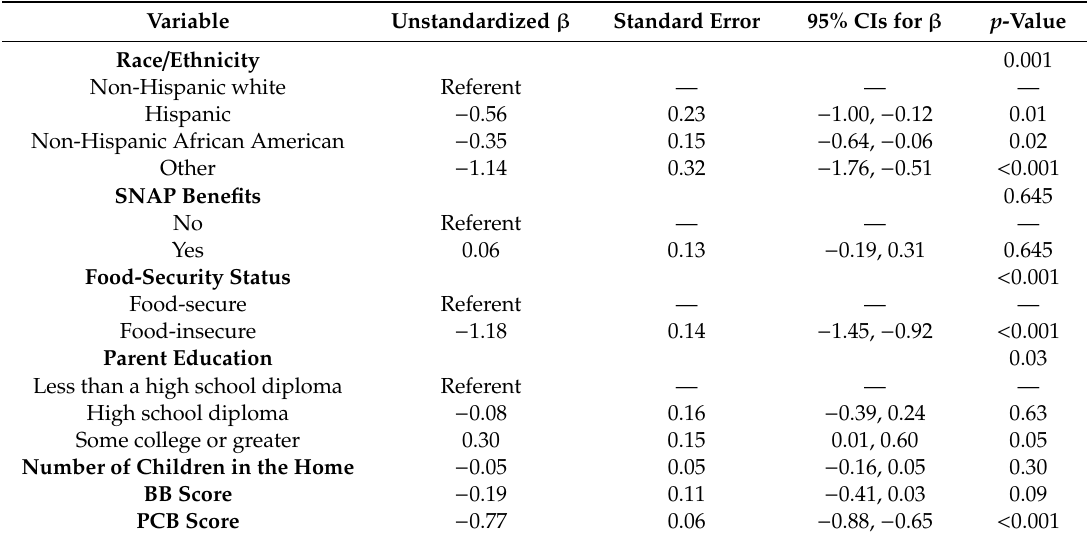
Table 3. Mixed-e ff ects linear regression model of the impact of barriers to buying and preparing / cooking vegetables on the home availability of vegetables score in food-secure and food-insecure households. Variable Unstandardized β Standard Error 95% CIs for β p -Value Race / Ethnicity